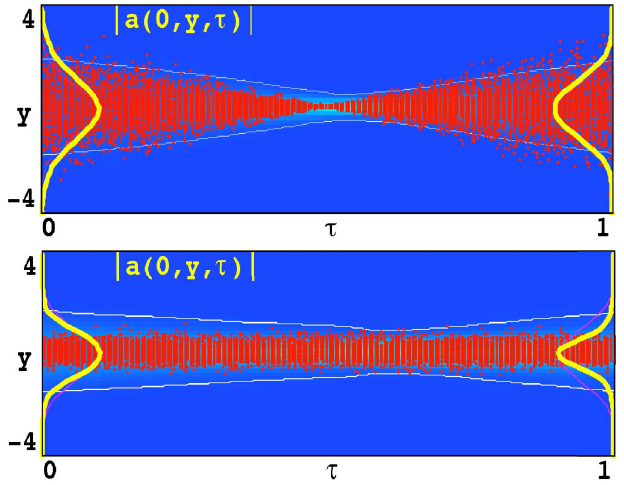
FIG. 10. (Color) A cross section of the optical mode amplitude, j a (cid:3) y; (cid:3) (cid:5)j , over a single pass through the undulator, from (cid:3) (cid:1) 0 ! 1 , for a narrow electron beam ( (cid:9) (cid:1) 0 : 03 , top) and a broad electron beam ( (cid:9) (cid:1) 0 : 3 , bottom). The red dots represent sample electrons. The white contour lines indicate 5% of the peak optical amplitude. The yellow curves on the left and right show the optical mode profile at the beginning and end of the undulator, respectively.